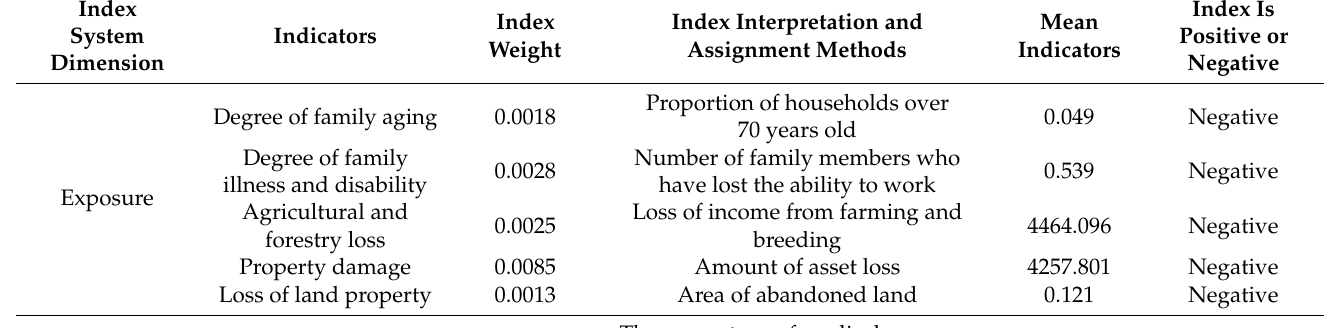
Table 3. Livelihood vulnerability evaluation index